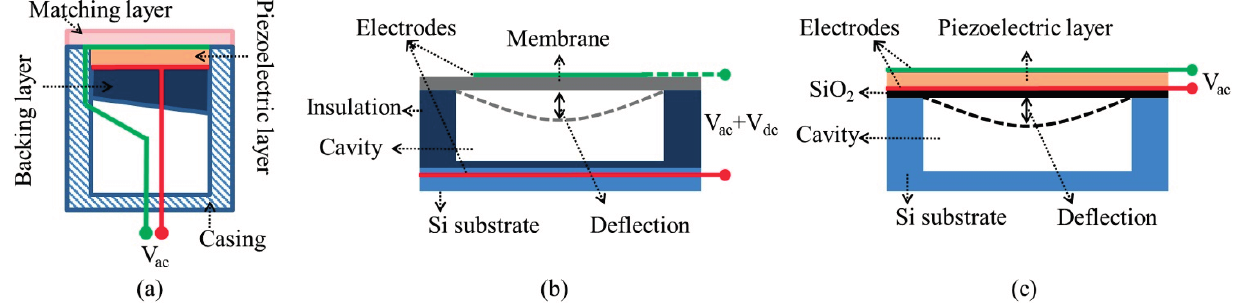
Figure 1. Typical cross-sectional structures of ( a ) piezoelectric ultrasonic transducers; ( b ) CMUTs and ( c ) d 31 -mode